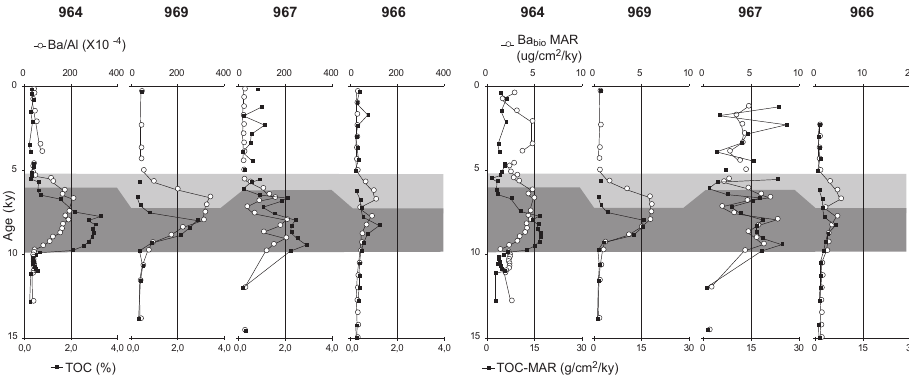
Fig. 2. Comparison of TOC and Ba/Al vs. TOC-MAR and Ba bio MAR for S1 on the four studied sites. Dark shade corresponds to visible sapropel layer. Light shade represents oxydized sapropel.